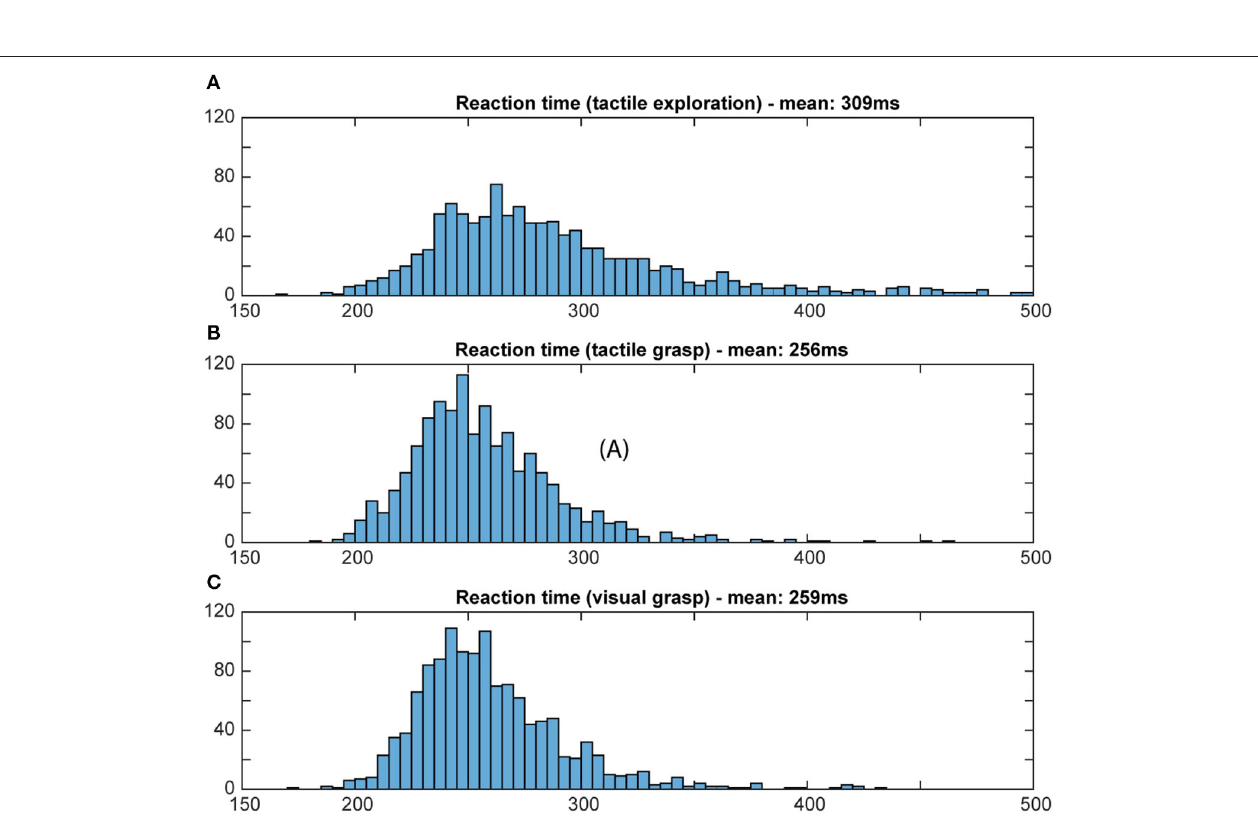
FIGURE 8 | Distribution of reaction time. Histograms illustrate how often a certain reaction time occurred during the grasp period in the tactile object exploration (A) and during grasping in tactile (B) and visual trials (C) . Bin width: 5 ms; cut off at 500 ms. For tactile exploration (A) , the slightly higher mean and larger variation of reaction time suggests hesitation, e.g., due to the unknown object, and less preparedness. For both tactile and visual grasping (B,C) , a similar distribution of reaction time was observed, indicating that the animal obtained in both tasks sufficient object information during the object presentation period to plan an appropriate grasp.